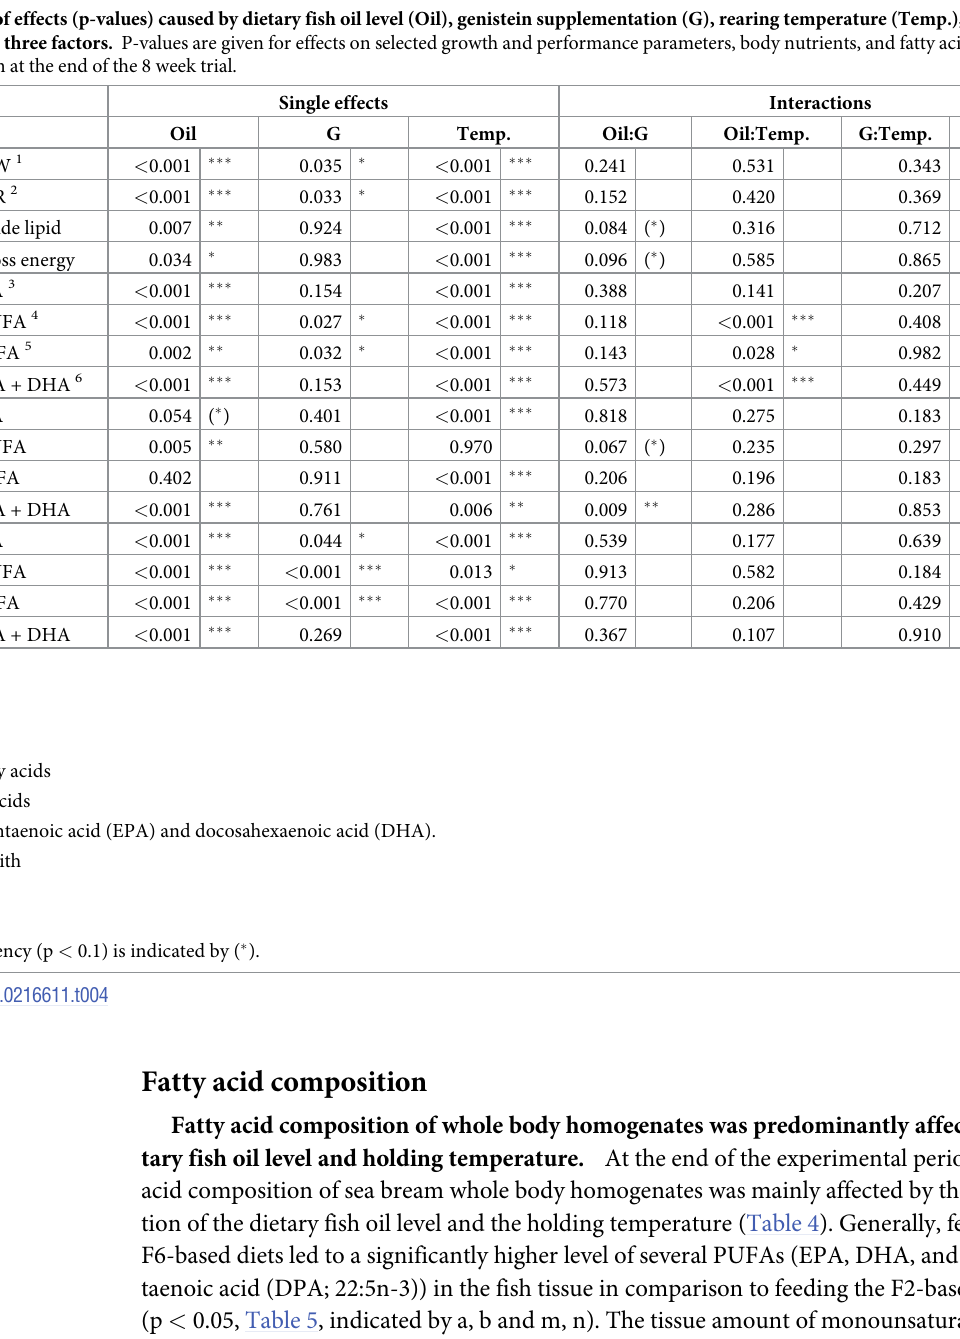
(p < 0.05, Table 5, indicated by a, b and m, n). The tissue amount of monounsaturated fatty acids (MUFAs) was affected the opposite way with higher values in F2-fed fish (p > 0.05, Table 5, indicated by a, b and m, n). These effects were visible in fish from both holding tem- peratures, although the difference was often higher in fish held at 23˚C. Dietary genistein caused only a slight, but significant, reduction of tissue MUFAs in fish fed with the diet F6 + G in comparison to fish fed with the diet F6 (p < 0.05, Table 5, indicated by A, B). This effect was temperature dependent and only visible in fish held at 19˚C. (dietary fish oil level, genistein, and holding temperature). At the end of the experiment,